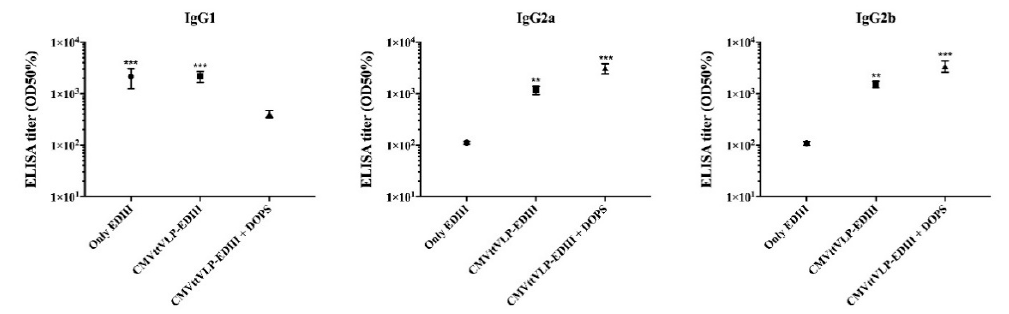
Figure 3. Subclasses of IgG. The figure shows the specific subclasses of IgG induced by each vaccine from samples collected three weeks after the third vaccination (Day 63). The group of mice vaccinated with only EDIII predominantly produced IgG1 while EDIII coupled to VLP (CuMVtt-EDIII) also induced IgG2a and IgG2b. When DOPS adjuvant was ad-mixed, this skewing towards IgG2a and b was even more pronounced. The results were analyzed using GraphPad Prism software applied to assess the means of three groups by one-way analysis of variance (ANOVA). The values observed in the negative control group were subtracted from the titers of the other experimental groups. Note: ** p < 0.001, *** p < 0.0001.